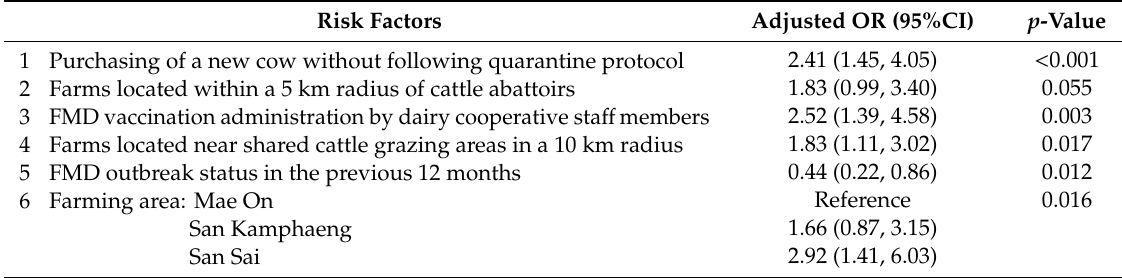
Table 3. Risk factors from the final logistic regression model for FMD outbreak in dairy farms. Risk